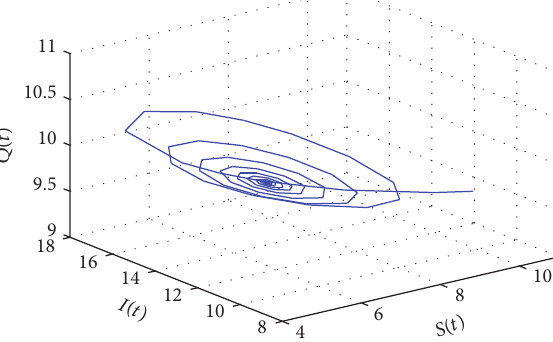
Figure 8: The phase plot of 𝑆 , 𝐼 , and 𝑄 when 𝜏 2 = 1.65 < 1.7852 = 𝜏 20 .